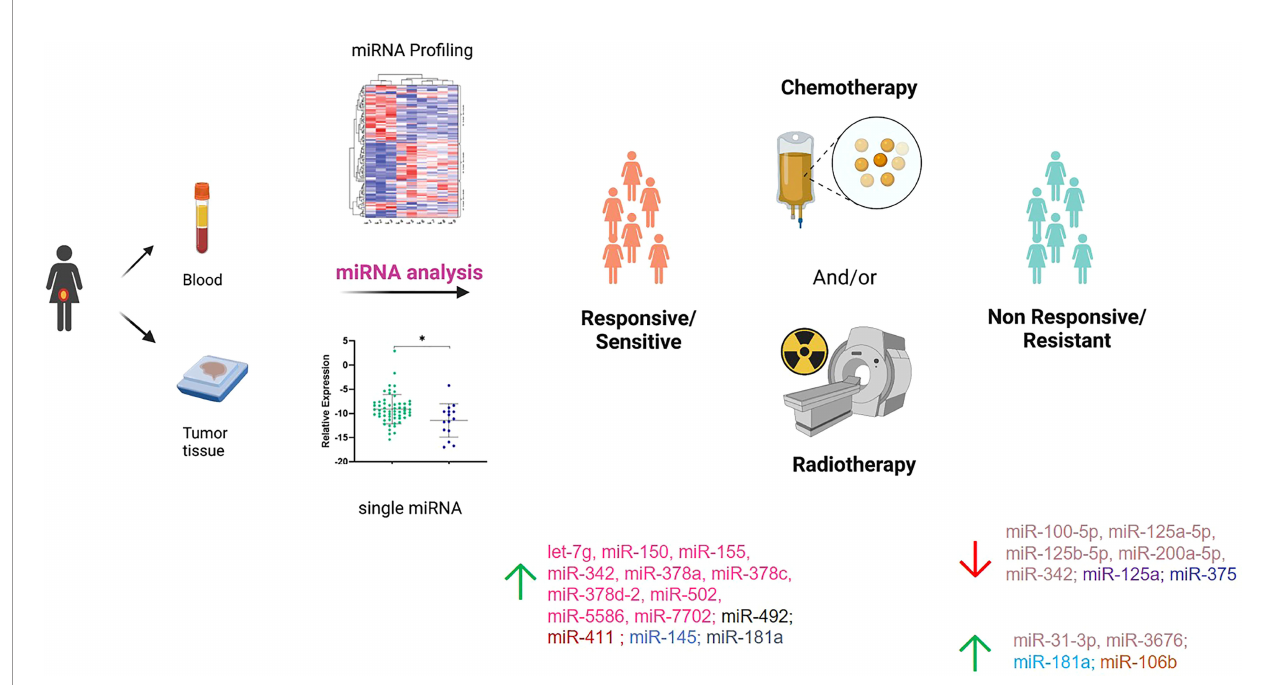
FIGURE 2 | Summary of the miRNAs investigated in responsive/sensitive vs. non-responsive/resistant cervical cancer patients. miRNAs highlighted with the same color derive from the same paper. Created in part with